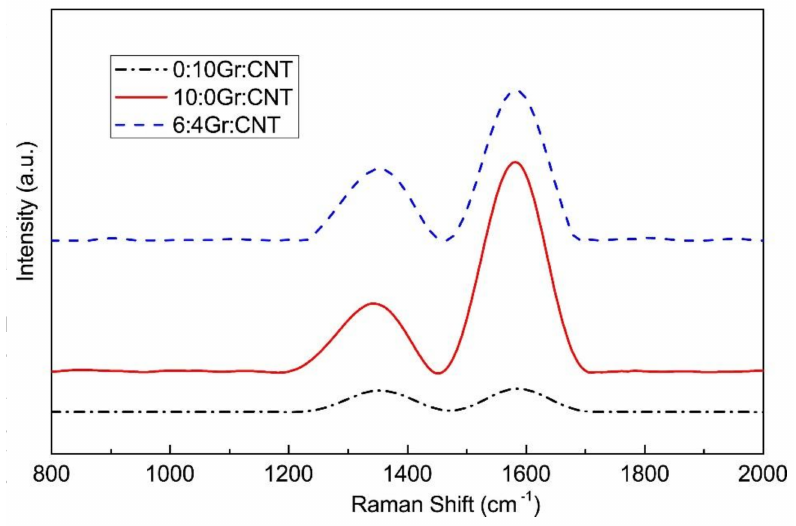
Figure 6. Raman spectrometry of PVA / SA / Gr / CNT nanofibrous membranes as related to Gr-CNT